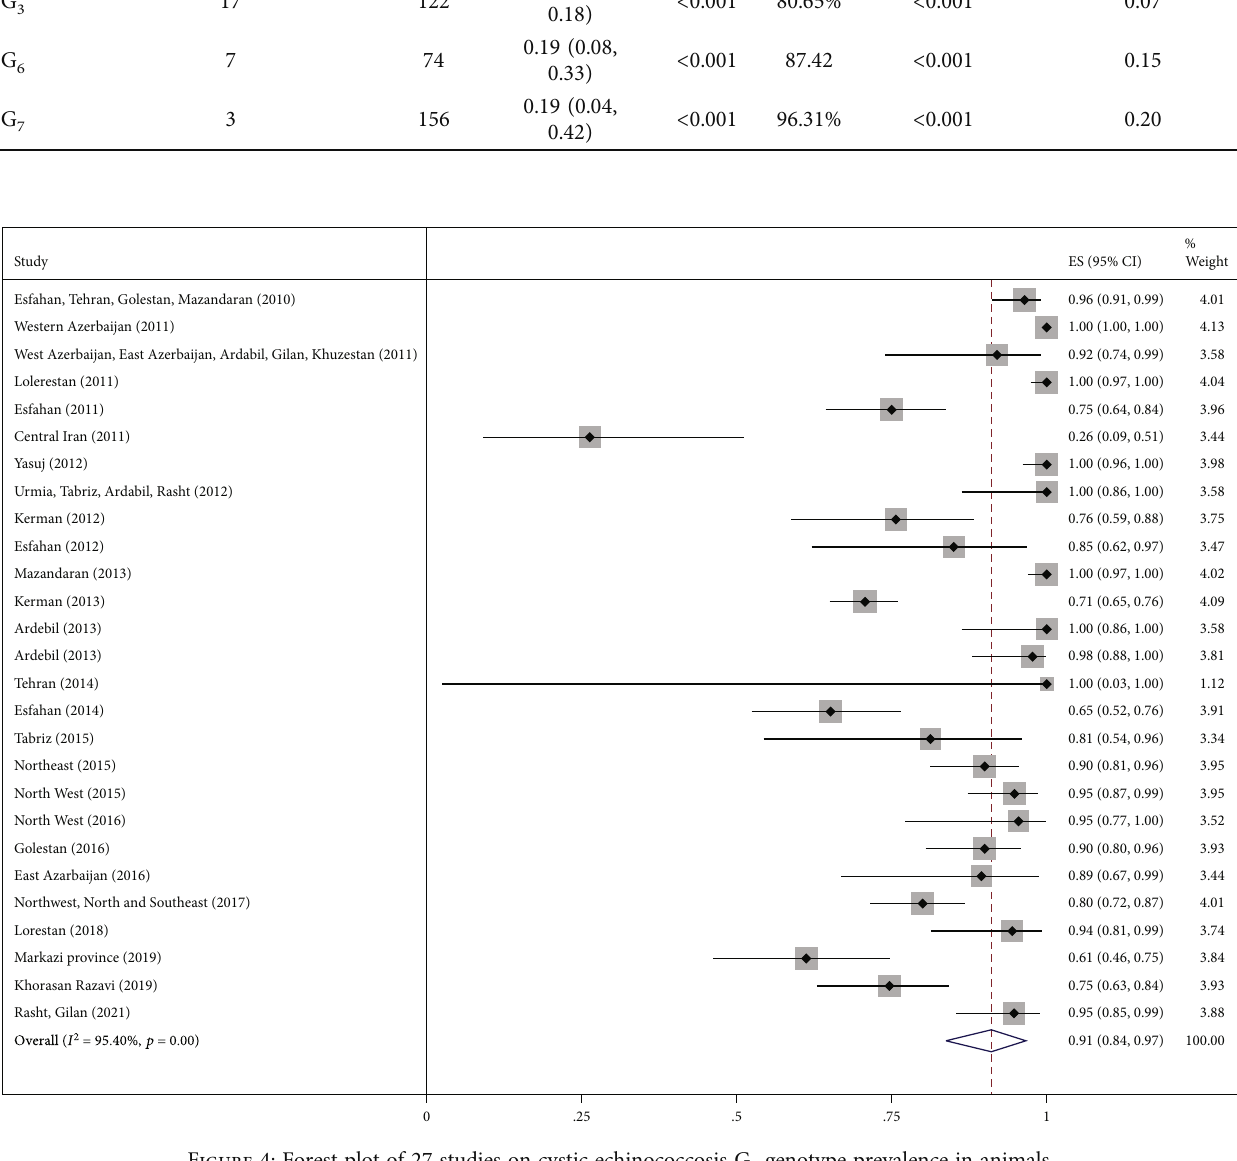
genotype prevalence in 1